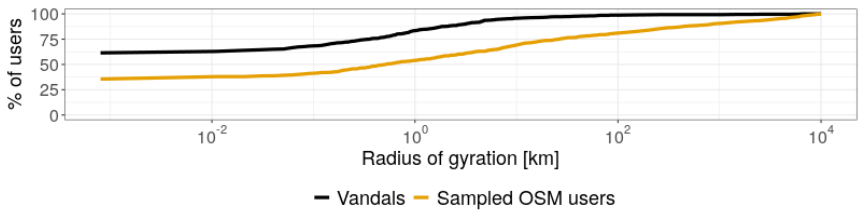
Figure 13. Cumulative curves of users with radius of gyration up to a given